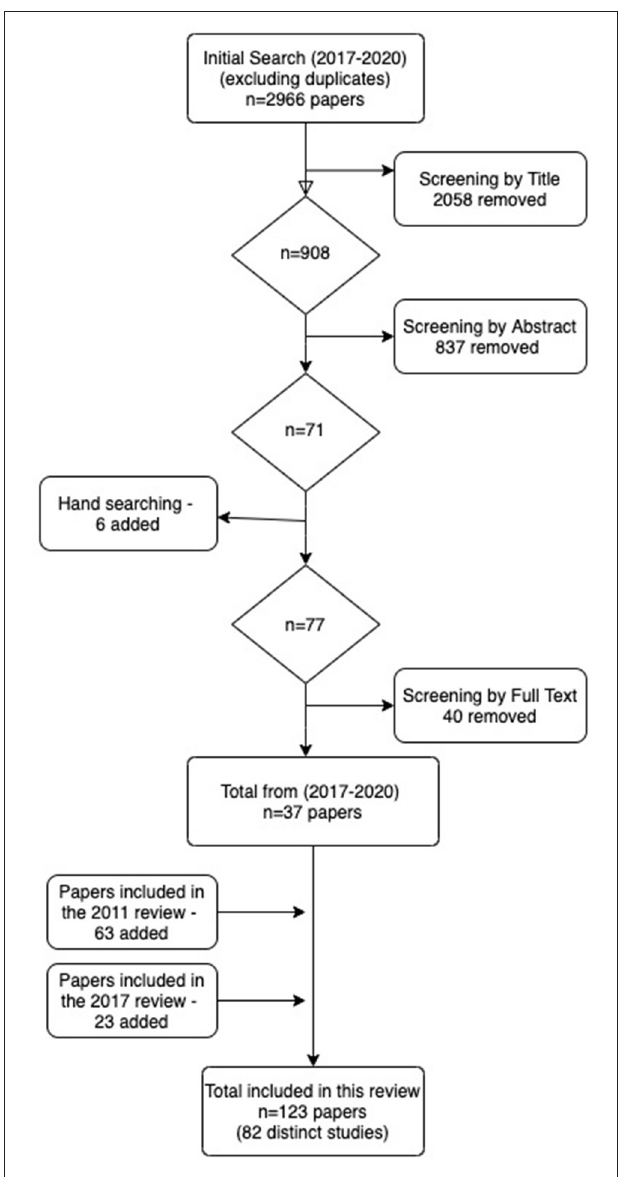
FIGURE 1 | PRISMA flow diagram of the study selection